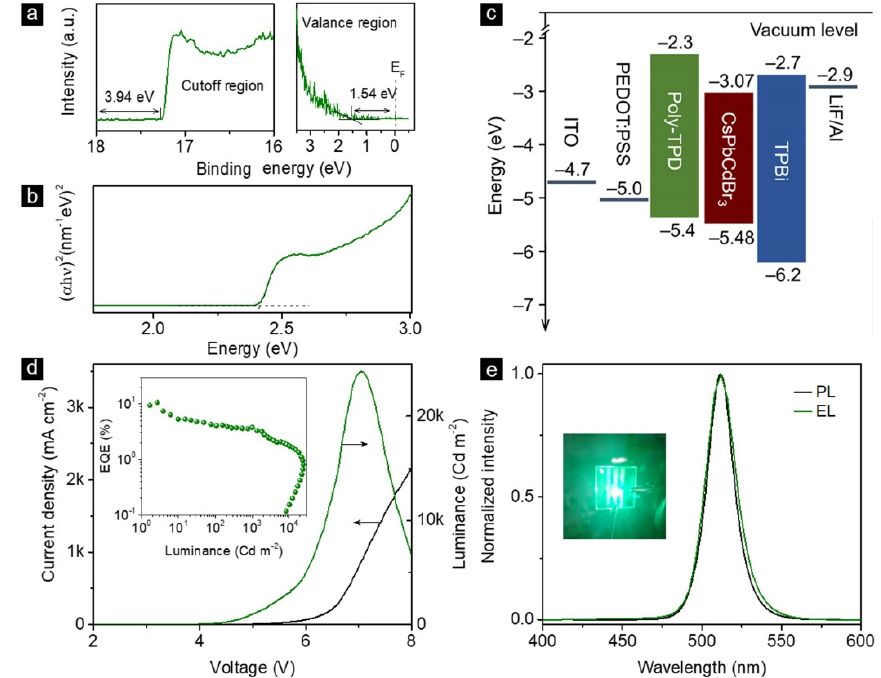
Figure 3. ( a ) UPS spectra for the cutoff (left) and valence (right) regions and ( b ) Tauc plot of the CsPb 0.78 Cd 0.22 Br 3 NCs film; ( c ) overall energy band diagram of the CsPb 0.78 Cd 0.22 Br 3 NC-based LED, ( d ) current density and brightness vs. driving voltage of the CsPb 0.78 Cd 0.22 Br 3 NC-based LED, ( e ) normalized PL and EL spectra for CsPb 0.78 Cd 0.22 Br 3 NCs in the film and LEDs; the inset is a photograph of the working LED.